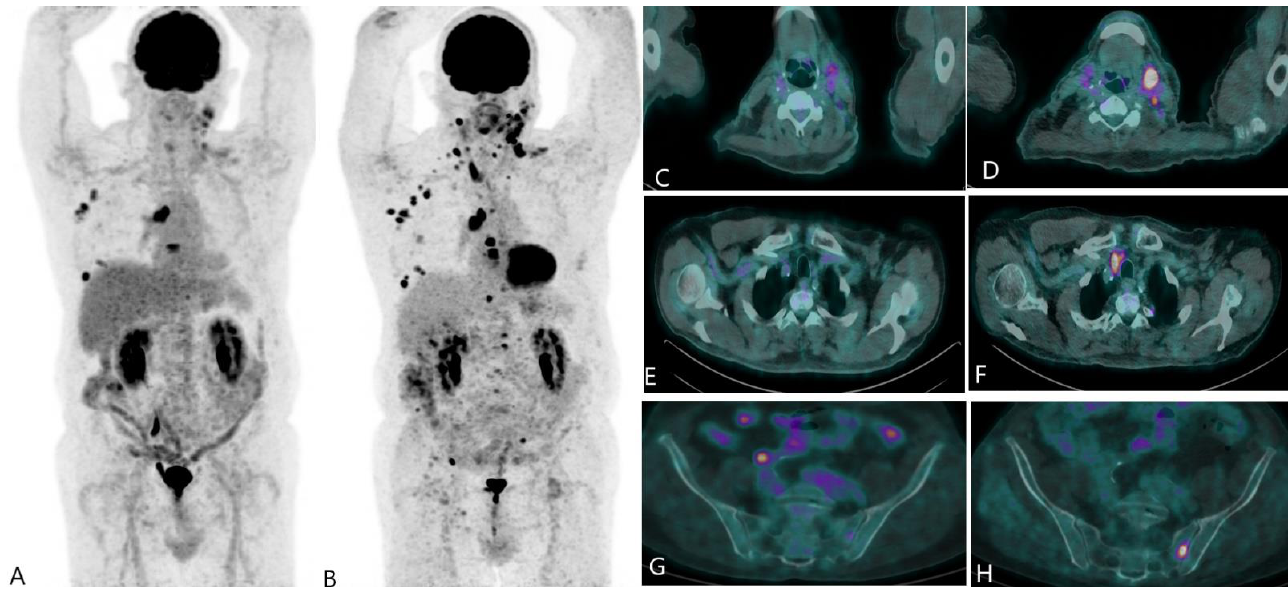
Figure 4. FDG PET/CT in recurrence disease and in evaluation of treatment response. A 65-year-old man was diagnosed with BR five years ago and treated by surgery, chemotherapy, and radiotherapy. He was referred for elevation of tumor marker and left cervical swelling. The PET/CT MIP image ( A ) shows a recurrence of disease, notably at left cervical, right axillary, and mediastinal lymph nodes, also a bone involvement at T7 and right ribs. The patient was treated then by capecitabine and the evaluation of treatment response was performed 5 months later. The PET/CT MIP image ( B ) of evaluation showed a progressive disease. Images ( C , D ) (fusion image, trans-axial view) show the morpho-metabolic progression of cervical lymph nodes. Images ( E , F ) (fusion image, trans-axial view) show the apparition of a superior paratracheal lymph node involvement. Images ( G , H ) (fusion image, trans-axial view) show the intensification of uptake of a bone lesion in the left